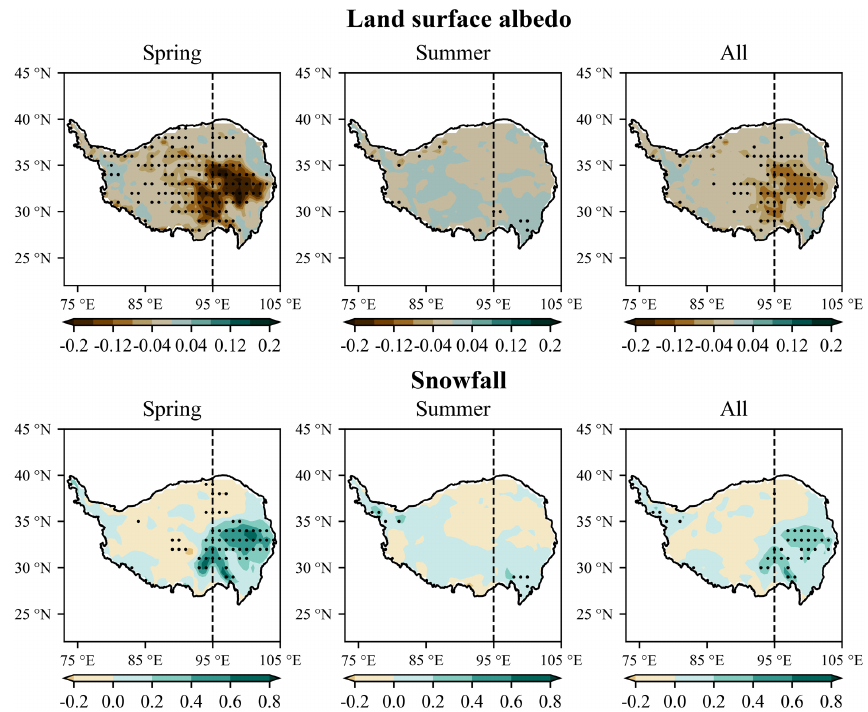
Figure 5. The spatial differences in land surface albedo (top row) and snowfall (bottom row; mmw.e. – millimeters of water equivalent) between the two ensemble reforecasts (the DA reforecasts minus the control reforecasts). The stippled regions show the statistical significance of the differences identified by the t test at a 5% significance